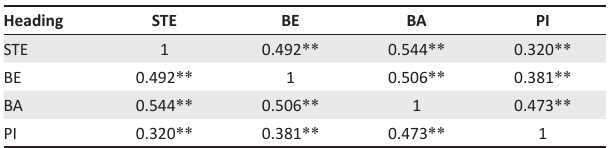
TABLE 3: Correlations matrix.